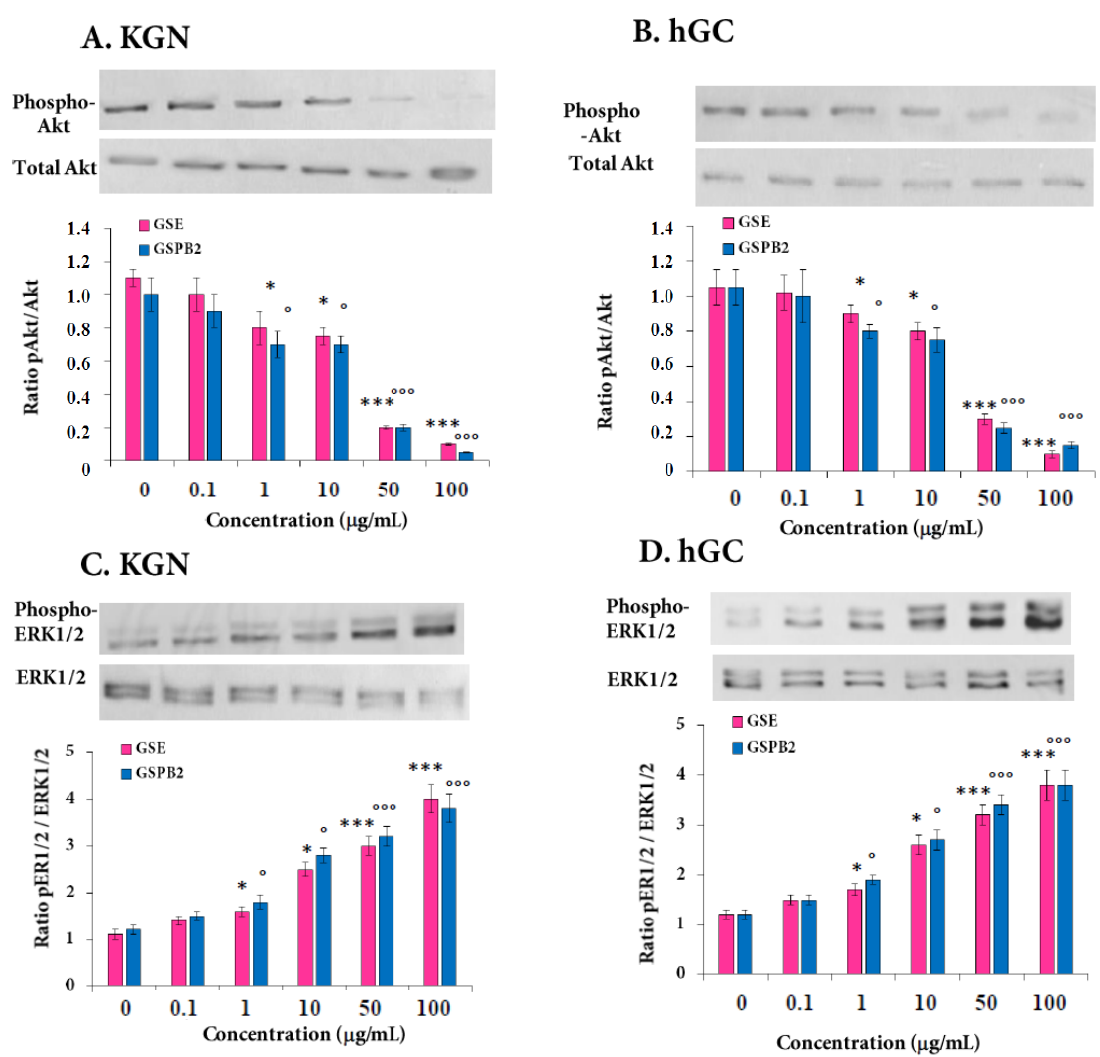
Figure 9. Dose e ff ect of GSE and GSPB2 on the phosphorylation level of Akt ( A , B ) and MAPK ERK1 / 2 ( C , D ) in human granulosa cells. KGN ( A , C ) and hGC ( B , D ) cells were cultured for 10 min in medium with serum in the presence or in the absence of various doses of GSE or GSPB2 (0, 0.1, 1, 10, 50, and 100 µ g / mL). Cells were then lysed and subjected to Western blotting with antibodies against phospho-Akt and Akt ( A , B ) and phospho-MAPK ERK1 / 2 ( C , D ). Representative blots in response to di ff erent concentrations of GSE are shown. Blots were quantified, and the phosphorylated protein / total protein ratio is shown. The results are presented as means ± SEM. * and *** represent a significant e ff ect of GSE as compared to the control at p ≤ 0.05 and p ≤ 0.001, respectively. ◦ and ◦◦◦ represent a significant e ff ect of GSPB2 as compared to the control at p ≤ 0.05 and p ≤ 0.001,